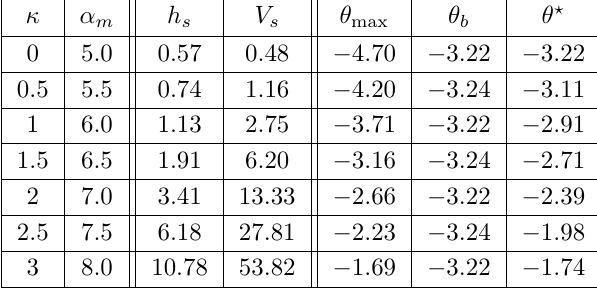
Table 2 . Spectral density’s persistent peak data for σ = 10 , α a = 3